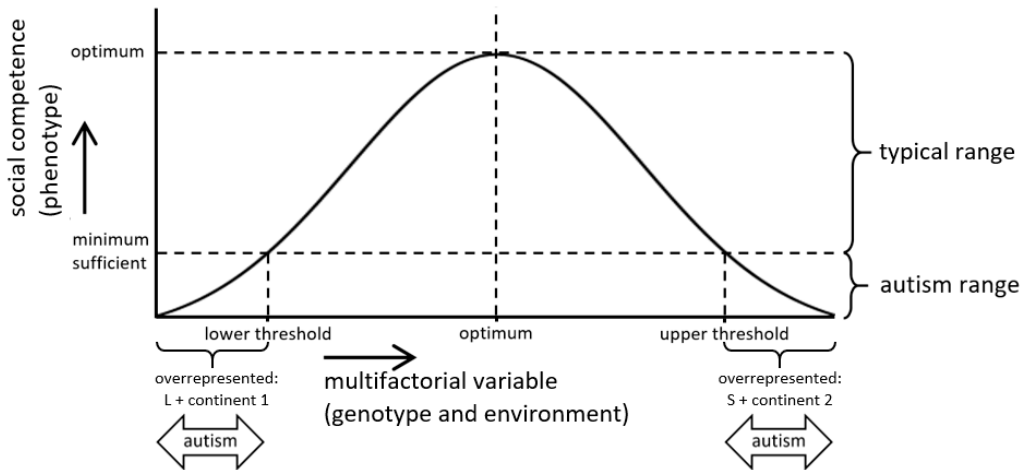
Figure 1. How an optimum curve can relate two alternative genetic variants to the same disorder. A hypothetical optimum curve represents a score for social competence (phenotype) as a function of a multifactorial biological variable (genotype and environment). Both the long (L) serotonin transporter gene-linked polymorphic region (5-HTTLPR) variant and a specific continental origin (continent 1) make a low contribution to this variable, whereas both the short (S) variant and an alternative continental origin (continent 2) make a high contribution. Two separate threshold values (lower and upper) mark the autism ranges of insu ffi cient social